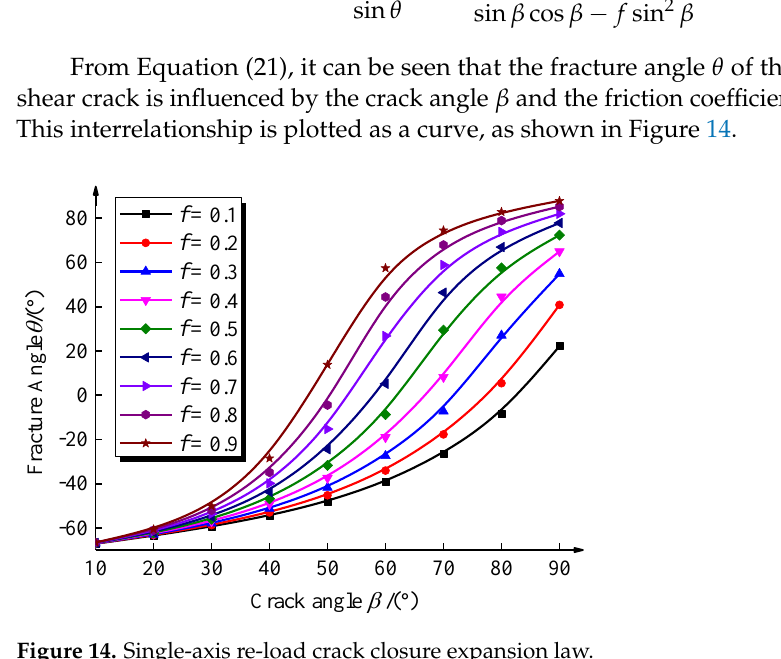
Figure 14. Single-axis re-load crack closure expansion law.